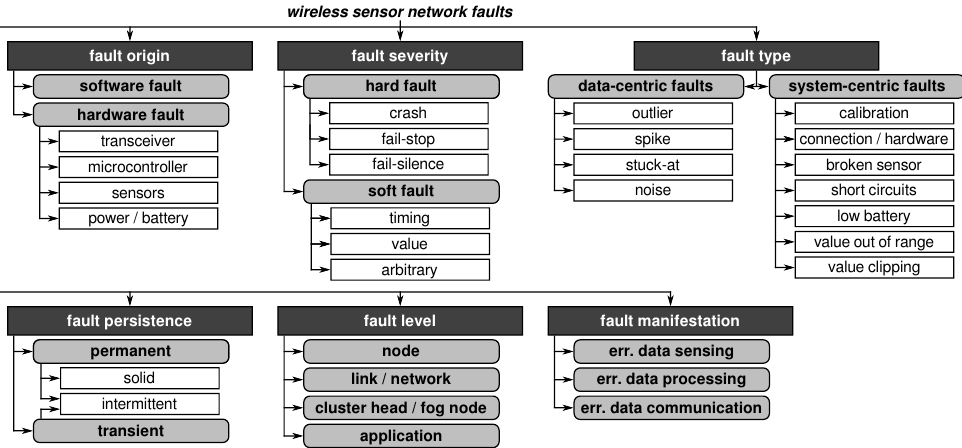
Figure 5. Wireless sensor network fault